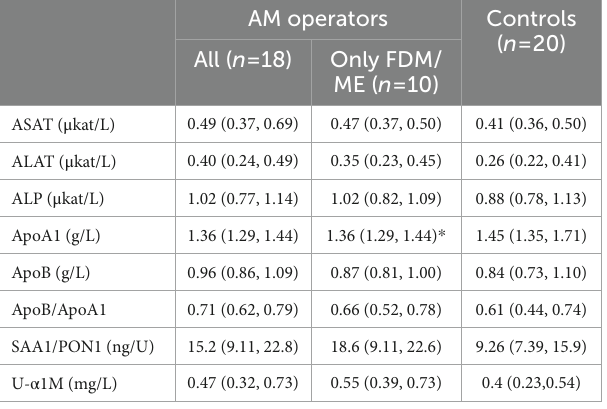
TABLE 4 Results from the clinical blood and urine